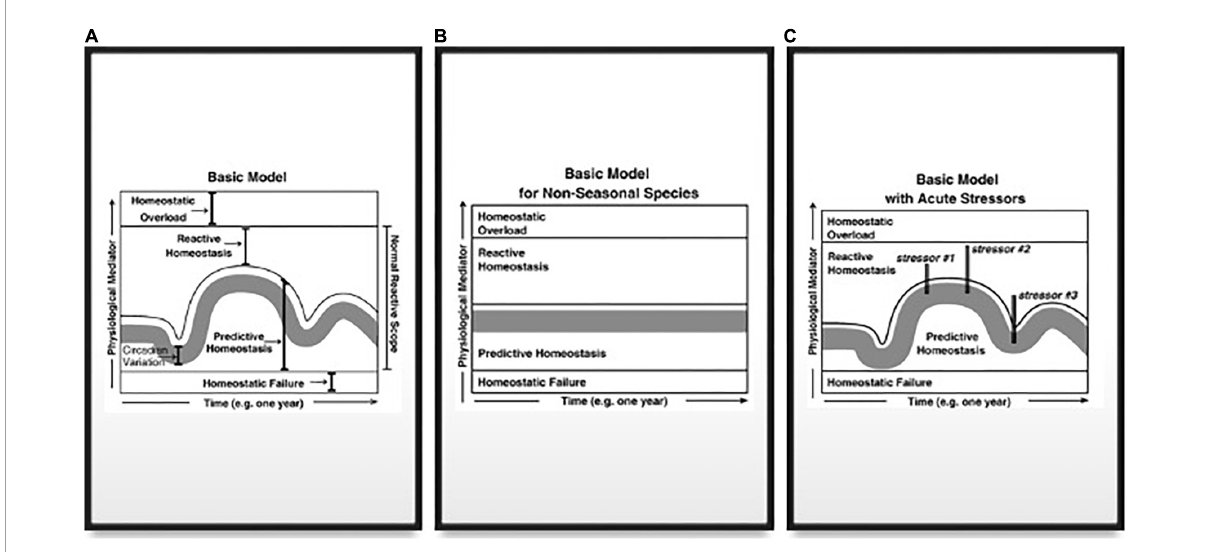
FIGURE4 (A) Graphical model of the concentrations of different physiological mediators on the y-axis vs. time. The range of concentrations or levels of physiological mediators is broken into four ranges. The lowest range depicts concentrations/levels that are too low to maintain homeostasis and is termed Homeostatic Failure. The minimum required concentration/level forms a threshold that does not change over time. Above this threshold is the Predictive Homeostasis range that varies according to predictable life-history changes. The circadian variation in concentrations/levels is depicted as a gray bar (with the bottom being the circadian nadir and the top being the circadian peak). The range of Predictive Homeostasis varies depending upon life-history demands, and thus changes seasonally. The Predictive Range extends slightly above the circadian peak in each season to encompass predictable daily events such as foraging. Above the Predictive Homeostasis range is the Reactive Homeostasis range, which represents concentrations/levels of the physiological mediator necessary to maintain homeostasis following an unpredictable event that threatens homeostasis. The Predictive and Reactive Homeostasis ranges form the normal reactive scope for that physiological mediator. The upper limit to the Reactive Homeostasis range is the concentration/level where the mediator itself starts to cause damage, and the range above this threshold is termed Homeostatic Overload. The threshold between Reactive Homeostasis and Homeostatic Overload is presumed to not change on a daily or seasonal basis. (B) A simplified version of the graphical model presented in (A) in a non-seasonal species such as humans. (C) A graphical depiction of the response to stressors. Each vertical line represents both a rapid spike of the mediator into the Reactive Homeostasis range in order to maintain homeostasis in the face of a stressor and a rapid decrease in the mediator once the stressor has ended. Stressor #2 is a stronger stressor than #1 and thus requires a stronger response to maintain homeostasis. Stressors #2 and #3 are of equivalent strength but occur at different times of year. Consequently, the mediator is at different concentrations/levels in the Predictive Homeostasis range so that stressor #3 is less likely to elicit a response from the mediator that extends into the Homeostatic Overload range. From Romero et al. (2009) with permission and courtesy of